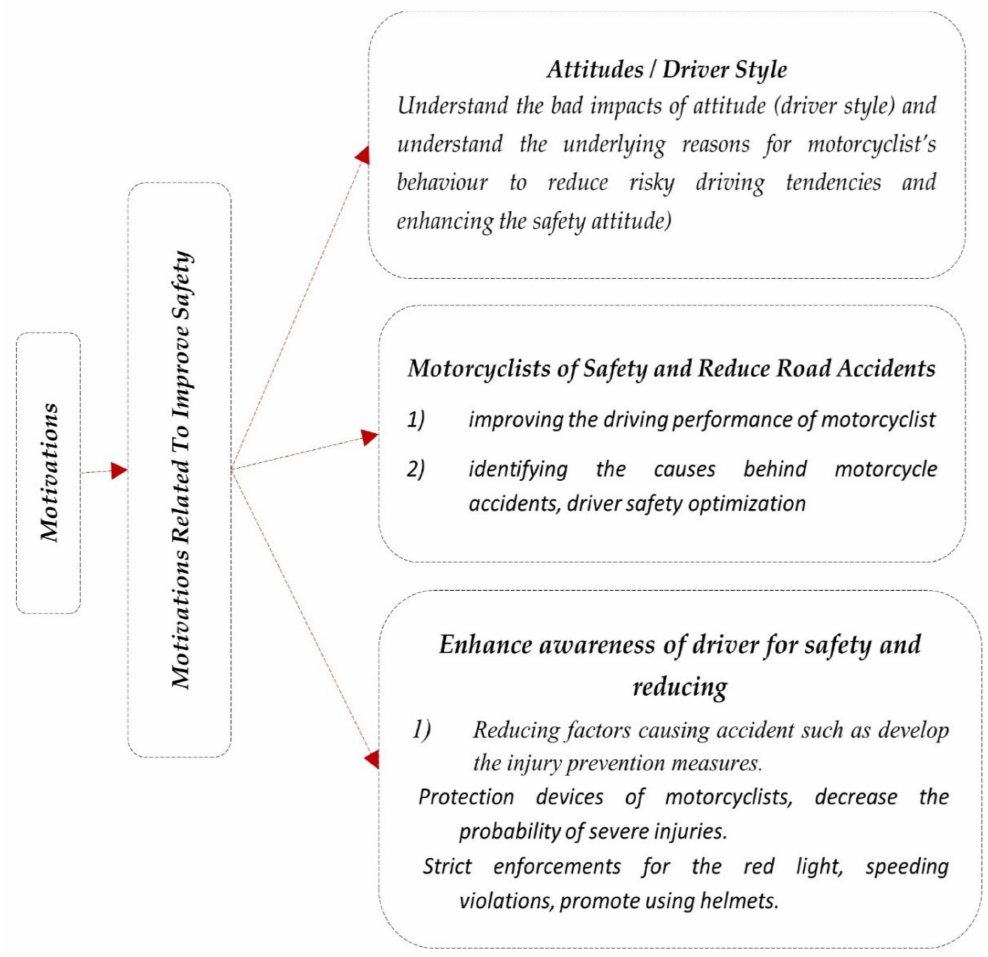
Figure 5. Motivation